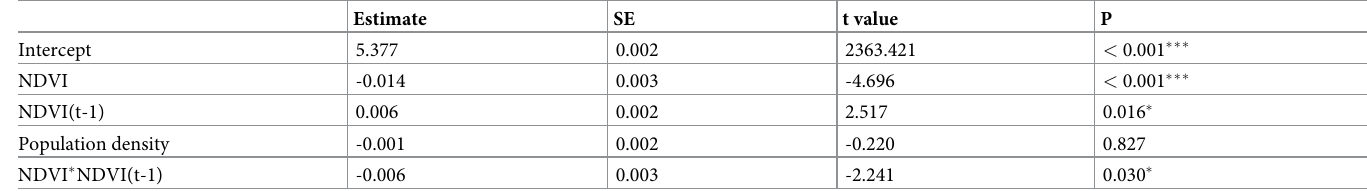
Table 2. Results of model 2 for the response variable rut peak date and the covariates NDVI in spring-summer just before the rut and NDVI in spring-summer of the precedent year (t-1).